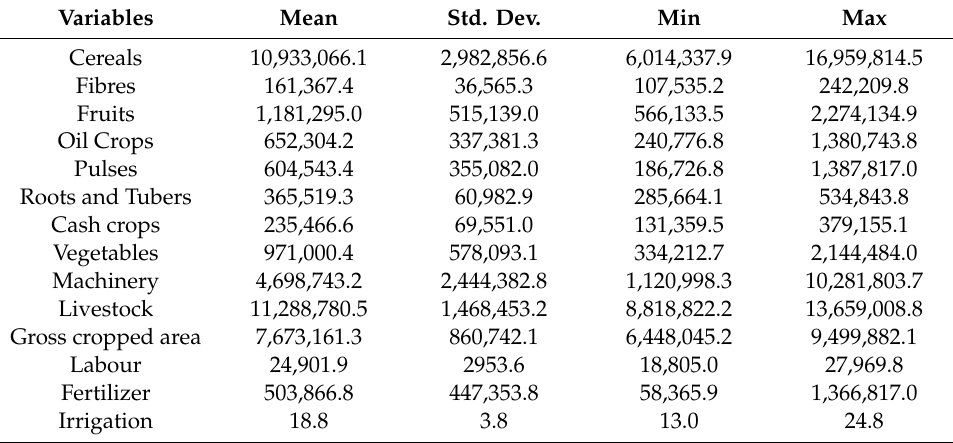
Table A2. Descriptive statistics of the input–output